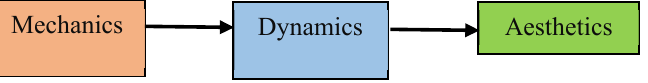
Fig. 2. MDA framework (Hunicke et al., 2004)